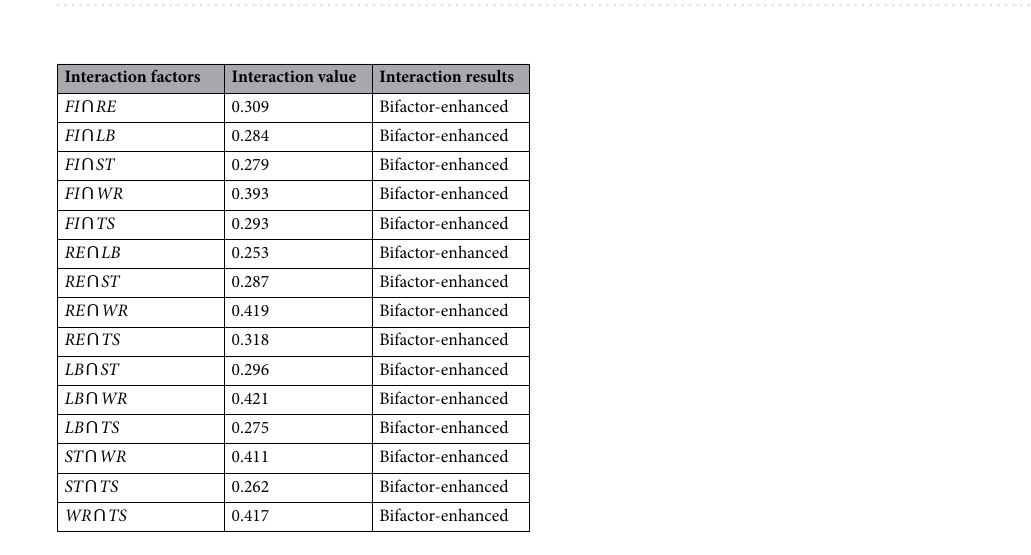
Table 5. Interaction detection